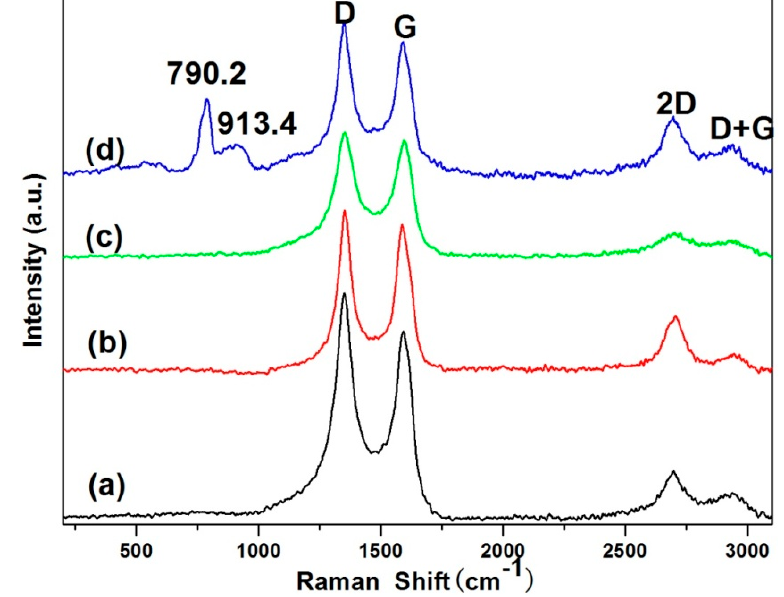
Figure 4. Raman spectra for composites at different stages: ( a ) The carbon felt, ( b ) felt/silica xerogel, ( c ) SiOC ‐ C/C preform, and ( d ) SiCNW ‐ C/C perform.